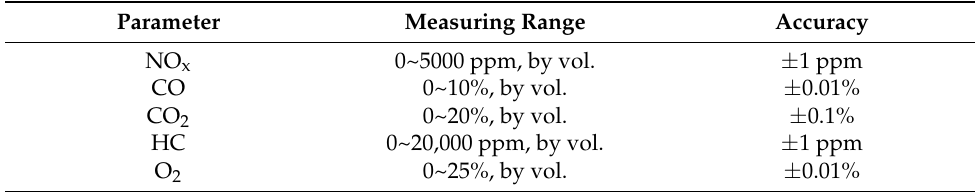
Table 2. AVL DICOM 4000 measurement range and accuracy.